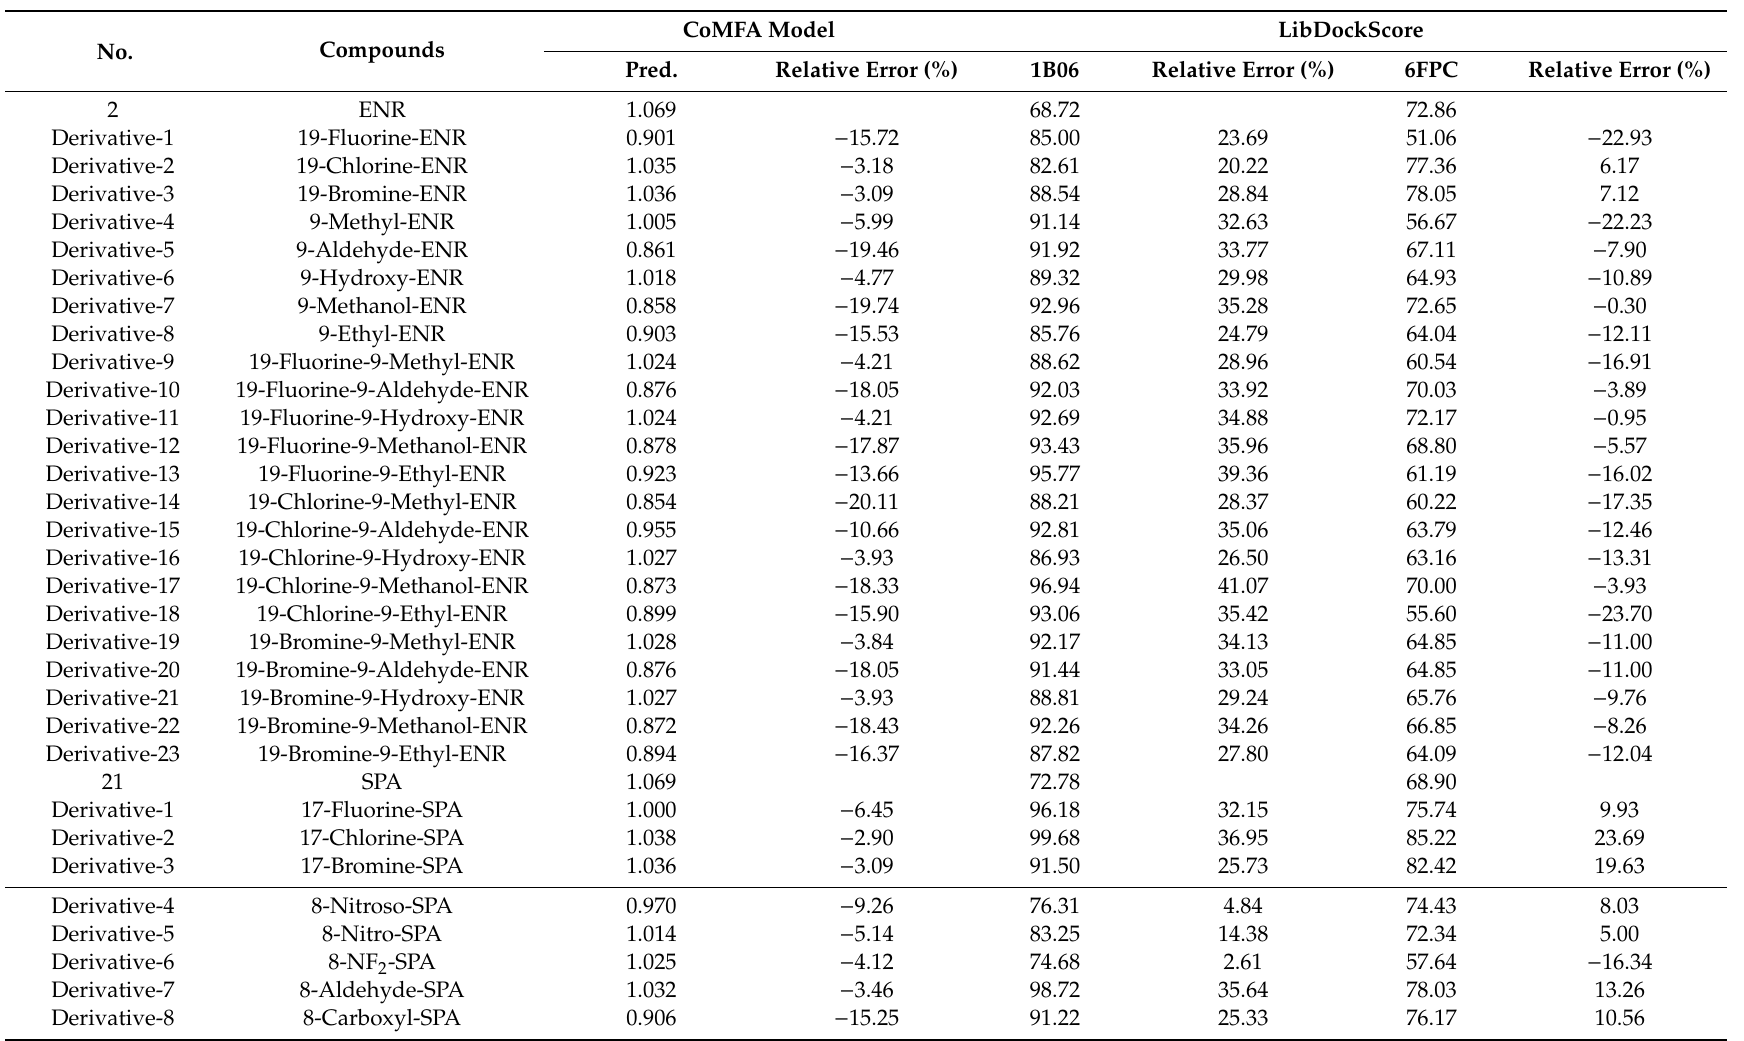
Table 4. Evaluation of biotoxicity of ENR and SPA